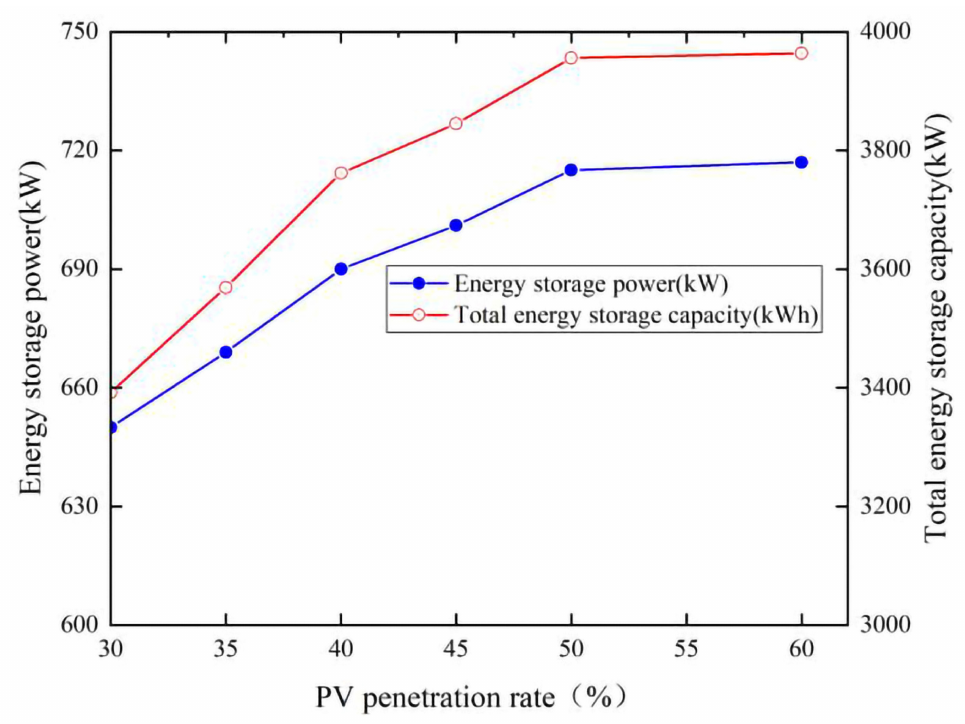
Figure 14. Changes in energy storage capacity and power under different photovoltaic penetration